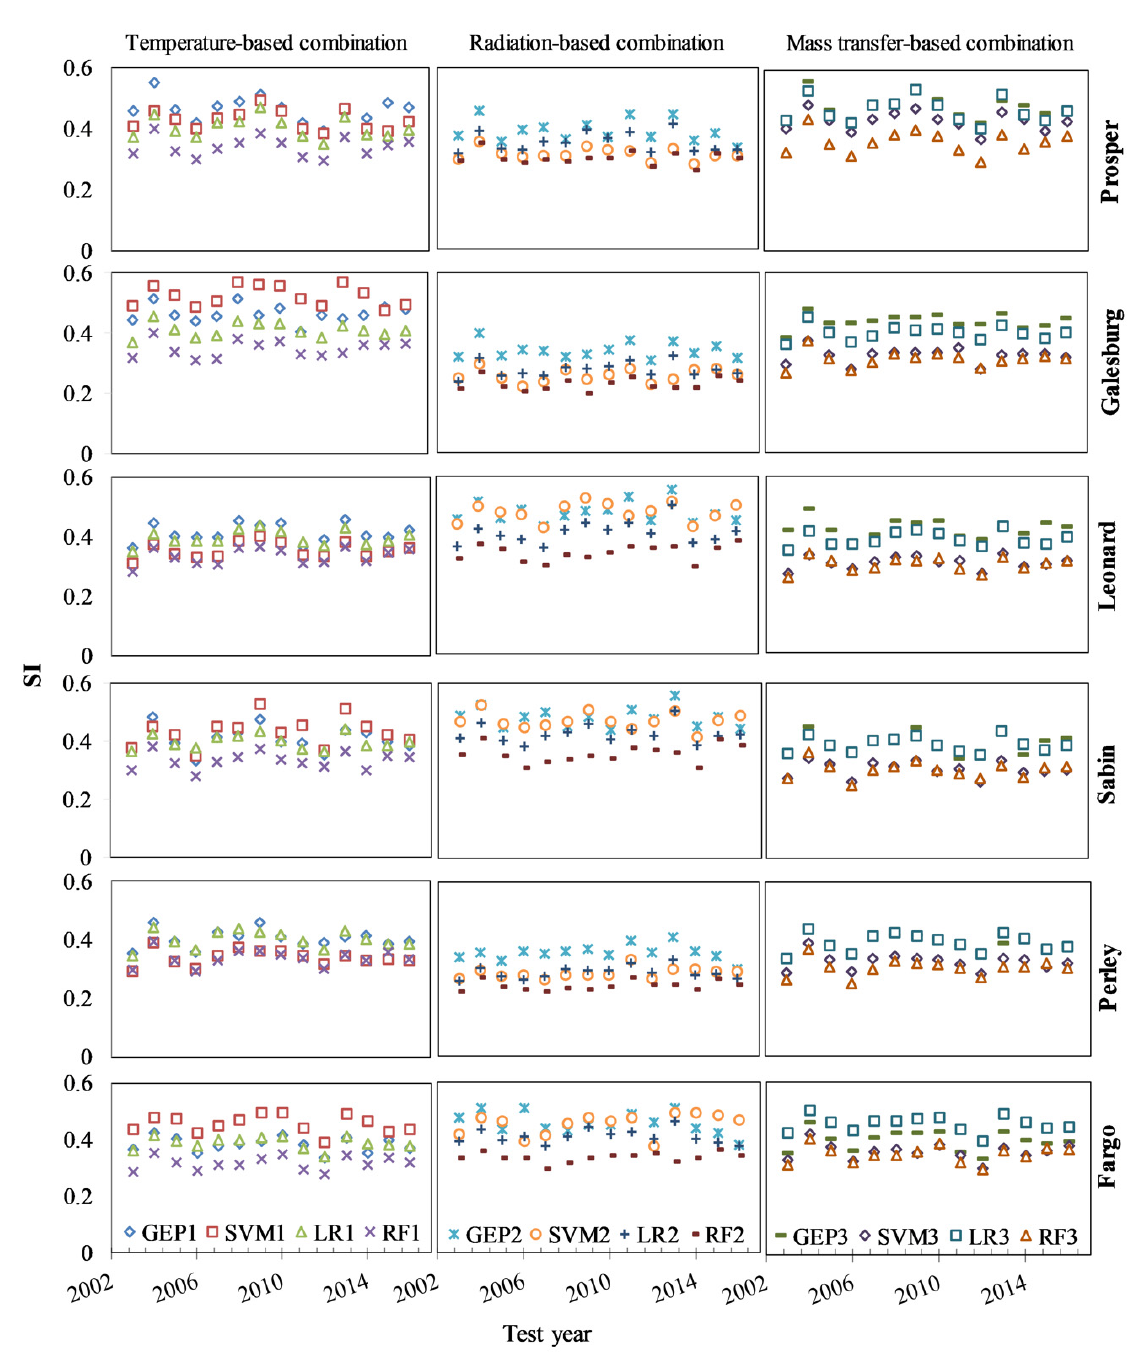
Figure 5. Scatter index (SI) values of GEP, SVM, LR, and RF models per test year and study station for three input combinations.